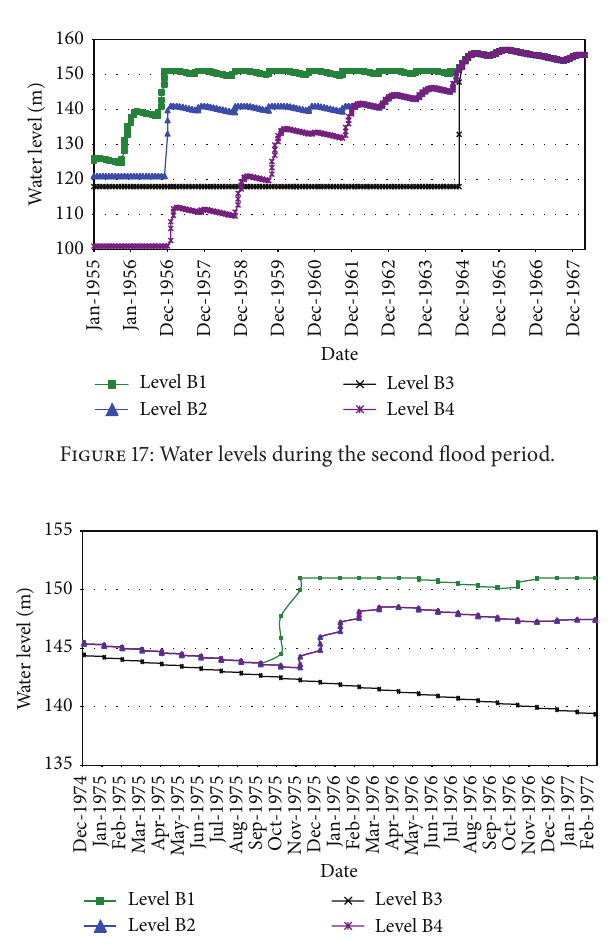
Figure 18: Water level variations during the draught period.